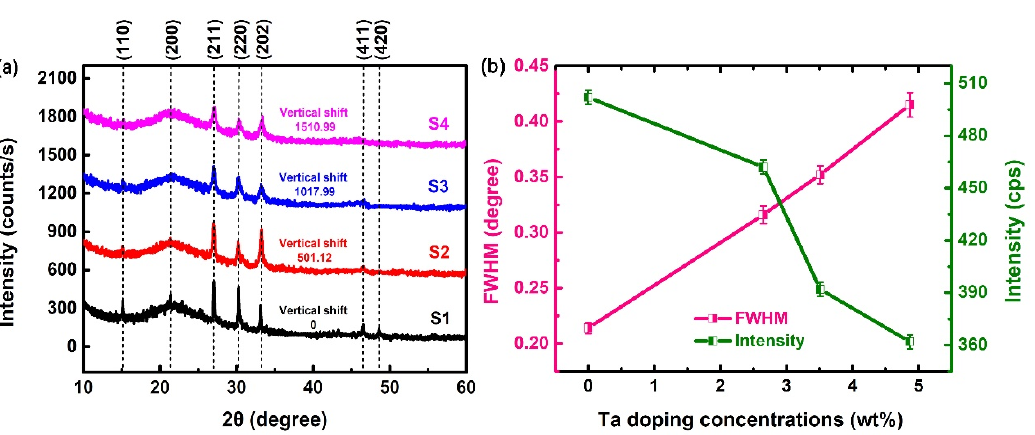
Figure 1. ( a ) XRD patterns of Ta-doped InTe thin films S1–S4; ( b ) variations of FWHM and intensity of the (211) peak.